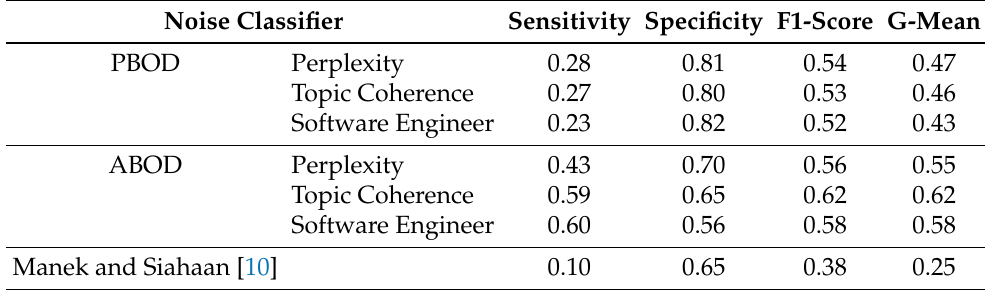
Table 3. Comparison of Performance between the Six Models and Previous Study.